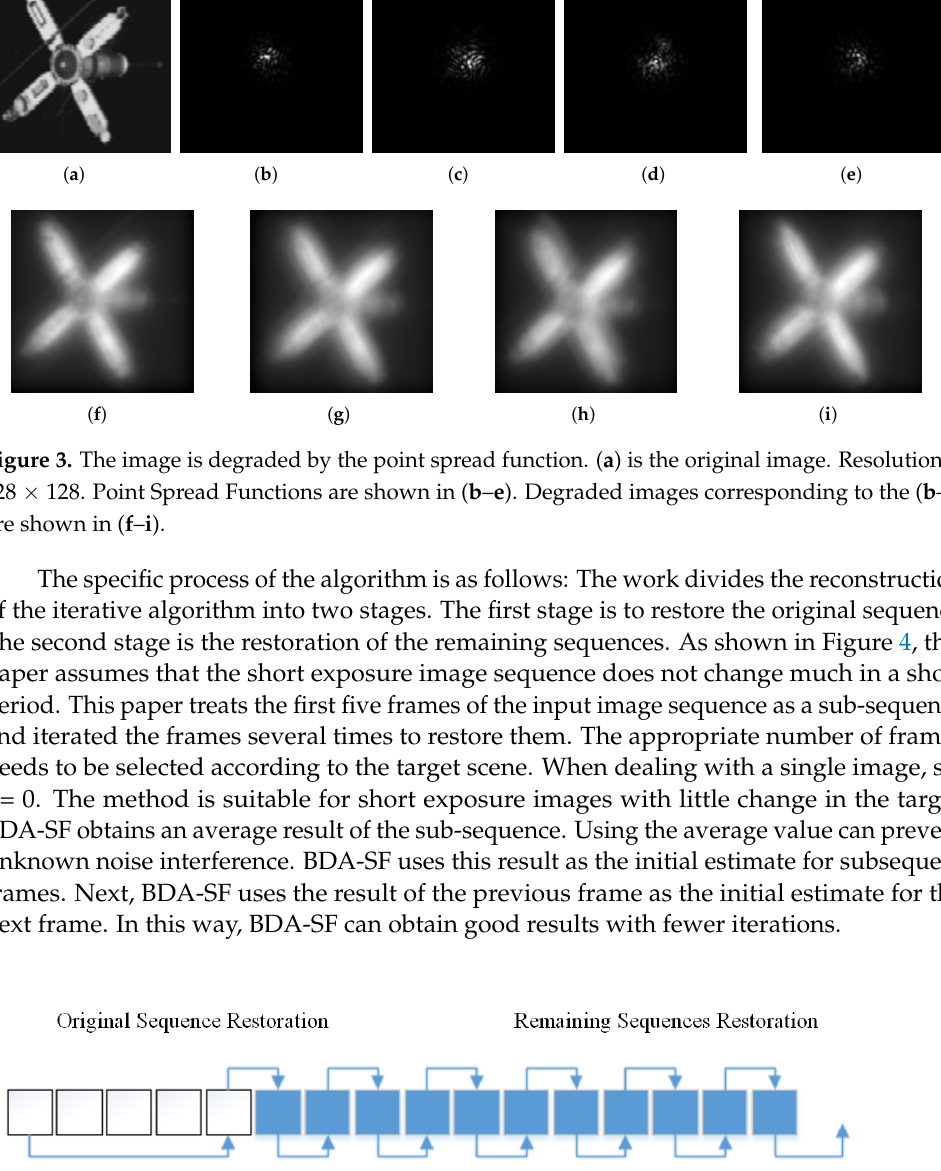
7 of 22 Figure 2. Image degradation under short exposure conditions. It is reasonable to assume that adjacent frames do not change significantly in a short period [51]. For image degradation by atmosphere turbulence, the displacement of the target image mainly comes from the degradation caused by turbulence rather than the target itself is change. Figure 3 simulates the image degradation caused by atmospheric